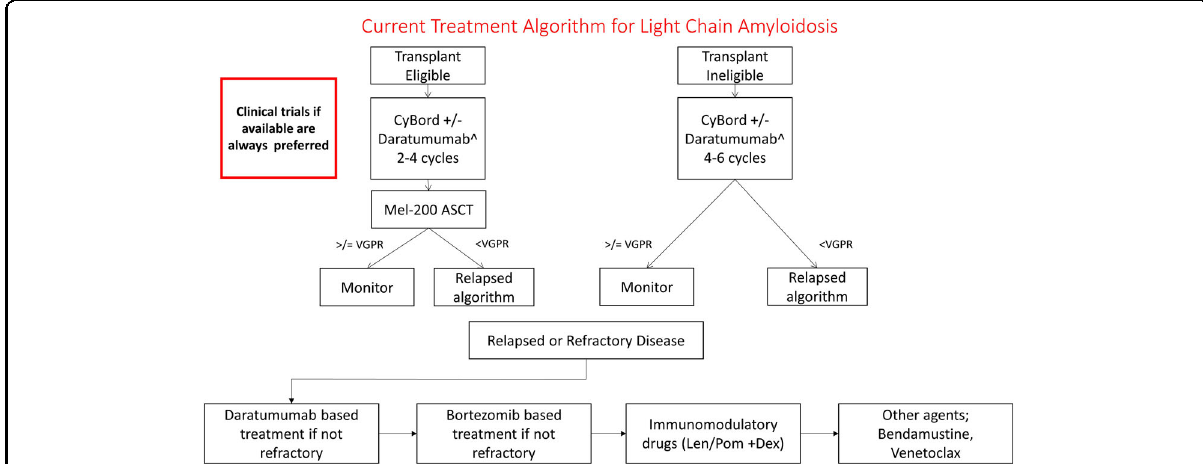
Fig. 2 Current treatment algorithm in light chain amyloidosis. CybBord cyclophosphamide, bortezomib, and dexamethasone, ASCT autologous stem cell transplant, VGPR very good partial response, Len lenalidomide, Pom pomalidomide, Dex dexamethasone. ^Where available induction with daratumumab plus CyBord is recommended. If unavailable CyBord is induction is recommended. *Daratumumab base treatment is preferred at fi rst relapse if patient is previously unexposed to this